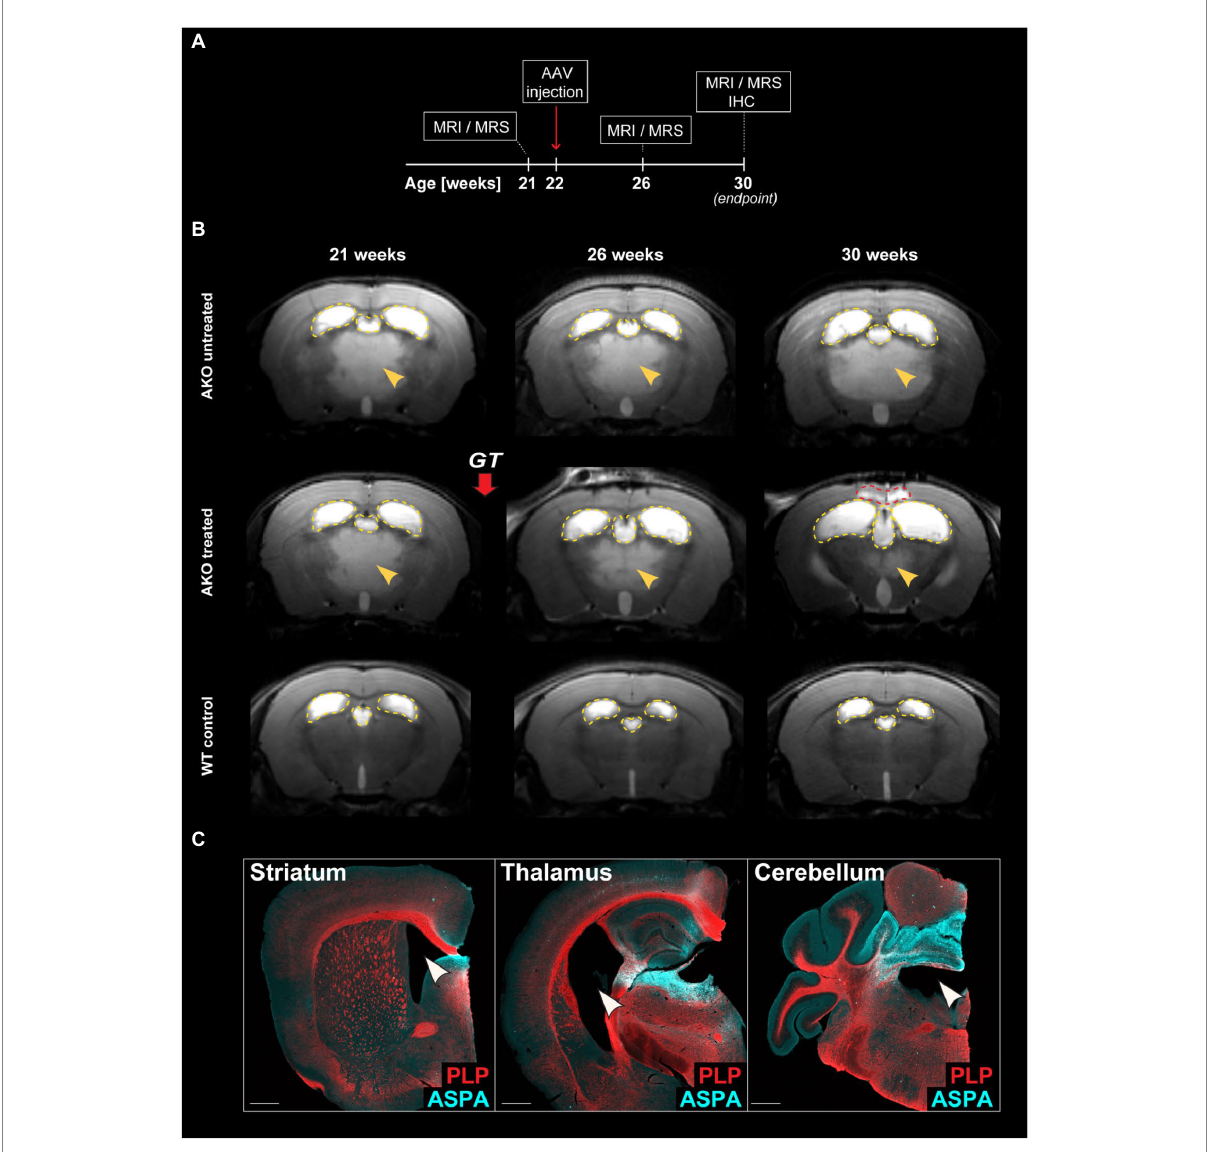
FIGURE 3 Dual function gene therapy in 22-week-old AKO mice with end-stage Canavan pathology reverses brain vacuolization but worsens ventricle dilation and neurological aspects of the disease. (A) Schematic depicting the study design for the treatment of AKO mice with end-stage Canavan pathology. (B) AAV.U6-shNat8l.1-MBP-coASPA vectors were injected bilaterally into striatum, thalamus, and cerebellum (3 × 10 9 vg per site) of 22-week-old AKO mice. Mice were imaged before as well as 4-and 8-weeks post gene therapy (GT). Representative T2-weighted brain MRI images are displayed. Yellow arrowheads indicate T2 hyperintensities reflecting spongiform vacuolization. Yellow dashed lines outline the lateral and third ventricles. Red dashed line hightlights the area of water ingress into the frontal cortex of 30-week-old treated AKO mice. (C) Coronal brain sections from the AAV injected regions (striatum, thalamus, and cerebellum) were immunolabelled 8 weeks after gene therapy. Ectopic ASPA expression (cyan) and the myelin marker proteolipid protein (PLP; red) are shown. Arrowheads indicate worsened ventricle dilation in treated AKO mice. Scale bars: 500 μ